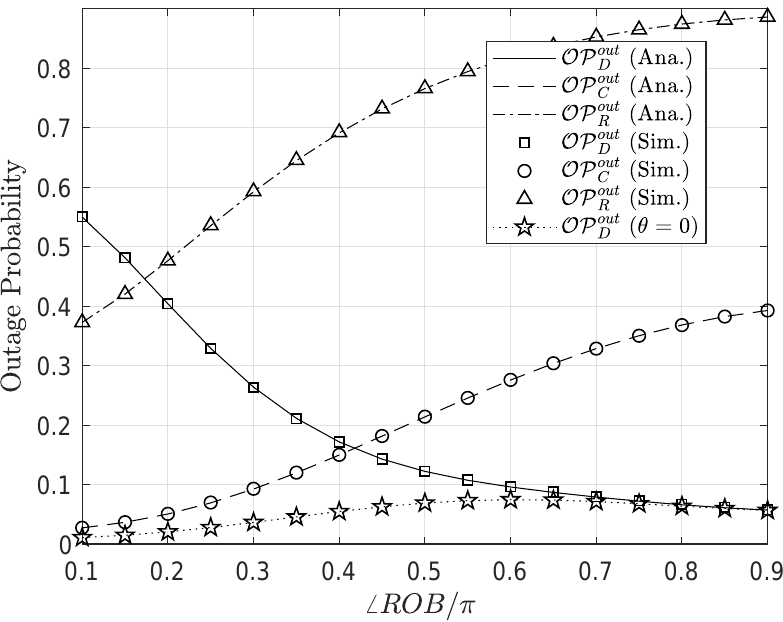
Figure 8. Outage performance versus the normalized angle (cid:54) ROB .